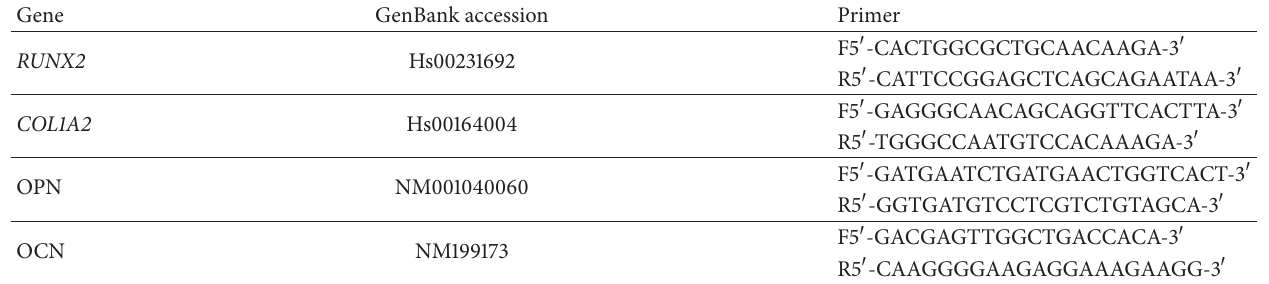
Table 1: RT-PCR primers